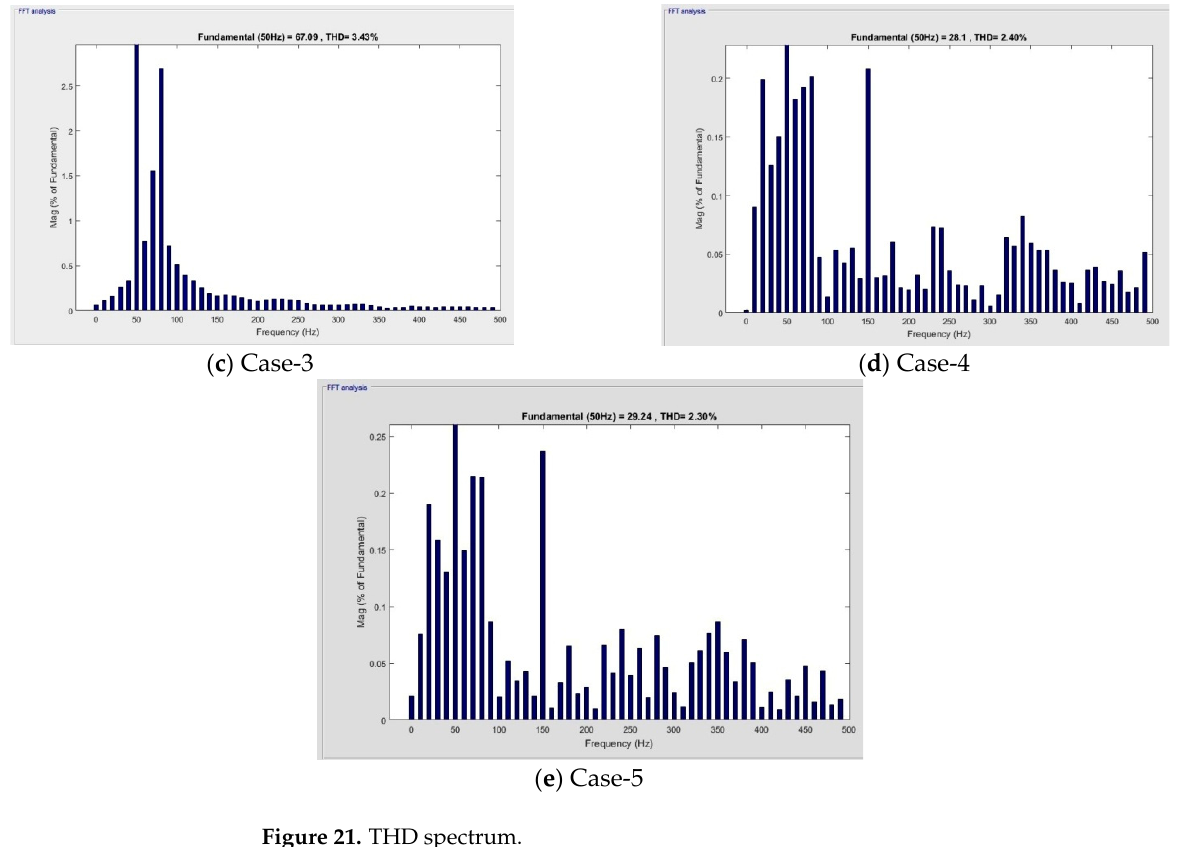
Figure 21. THD spectrum.